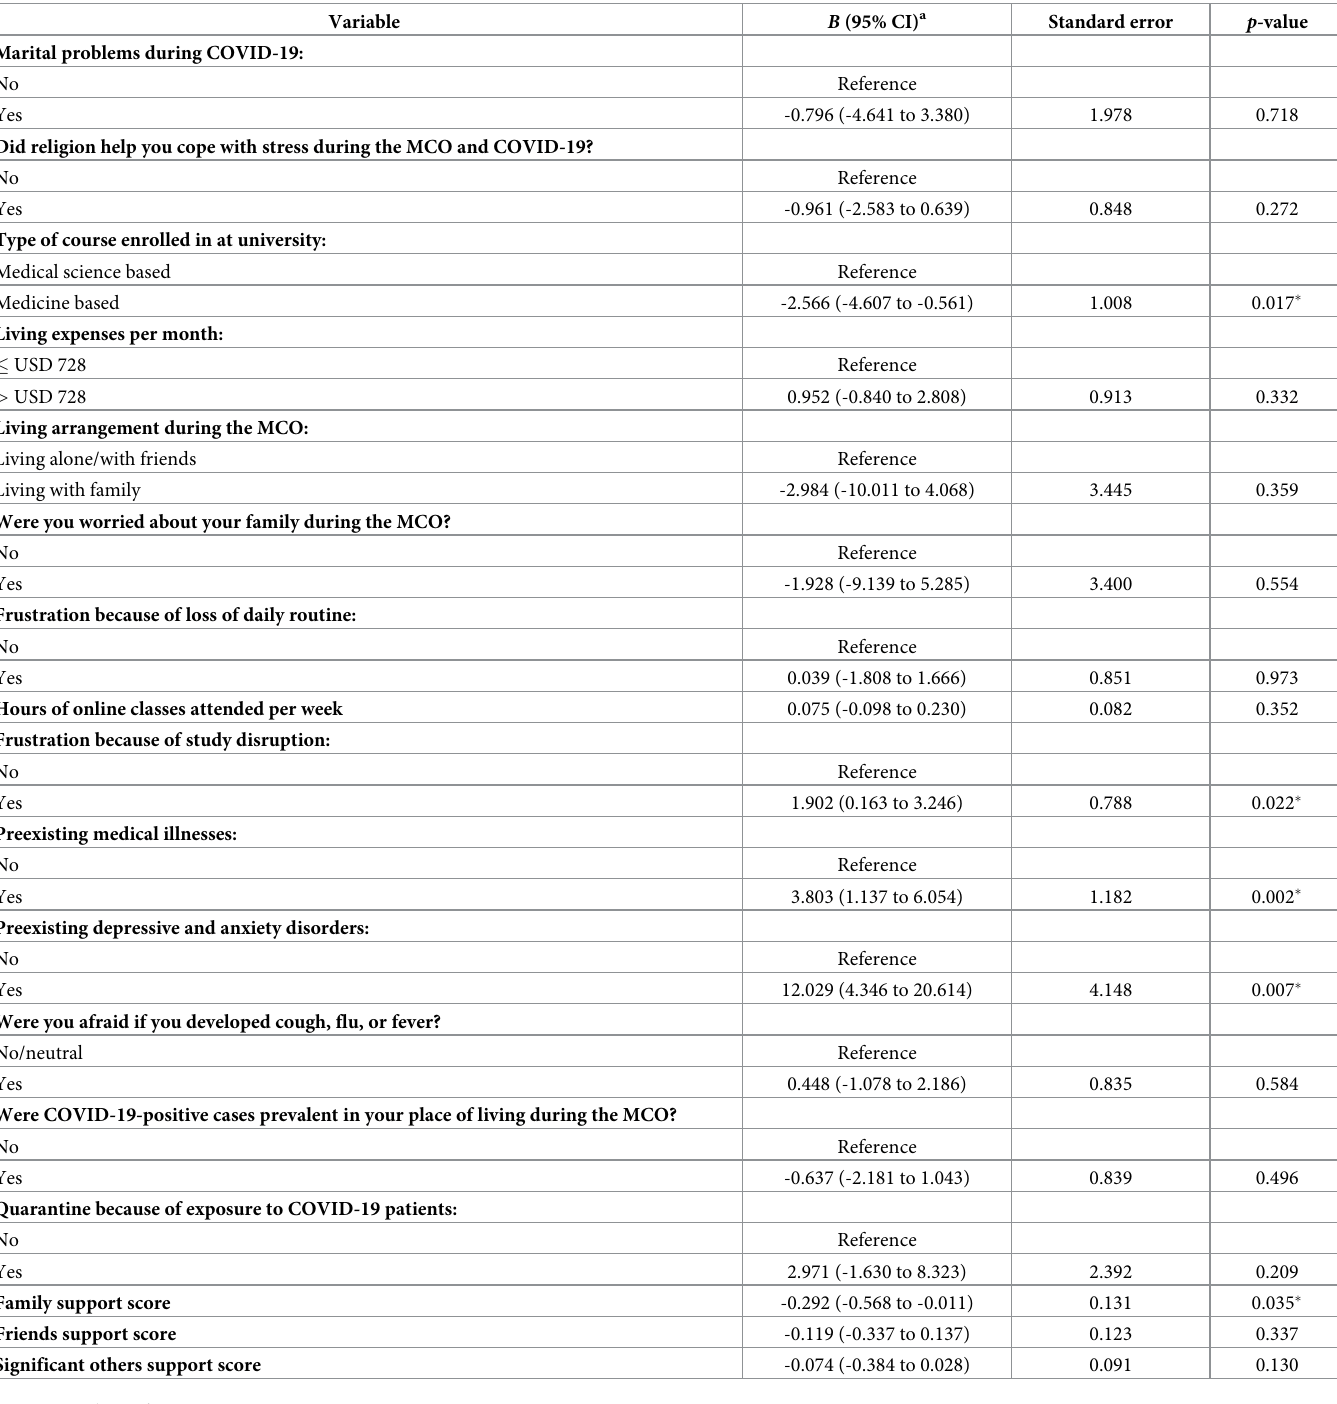
Table 4. Association between various COVID-19 stressors, religious coping, personal and clinical factors, and social support on one hand and the level of anxiety symptoms on the other among the